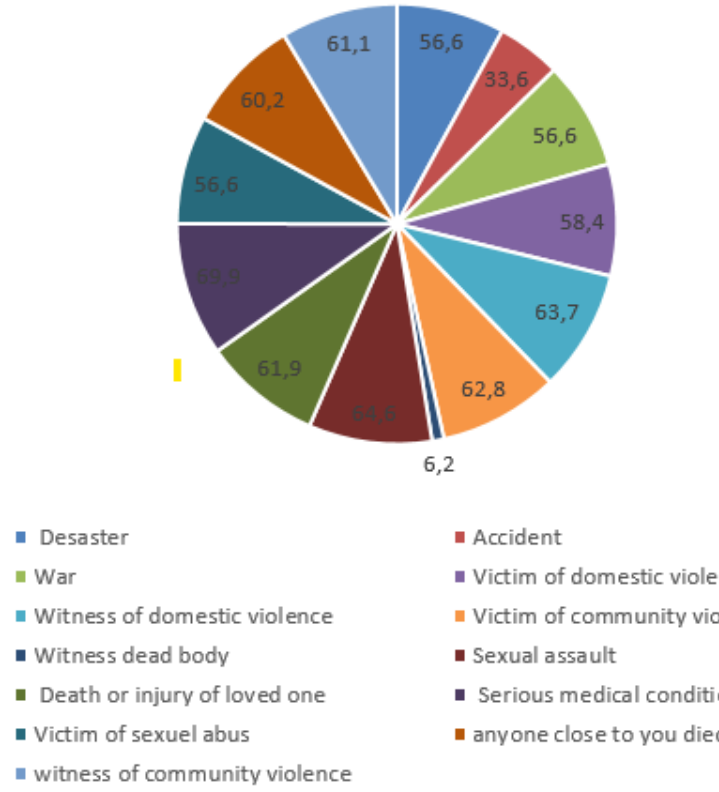
Figure 1. Rate of exposure to traumatic events among primary school students.